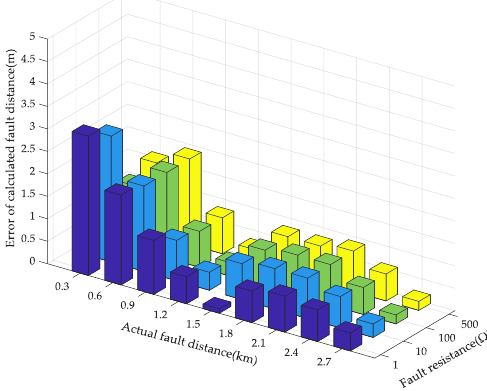
Figure 5. Error of computed fault distance for a-g fault on PT section.